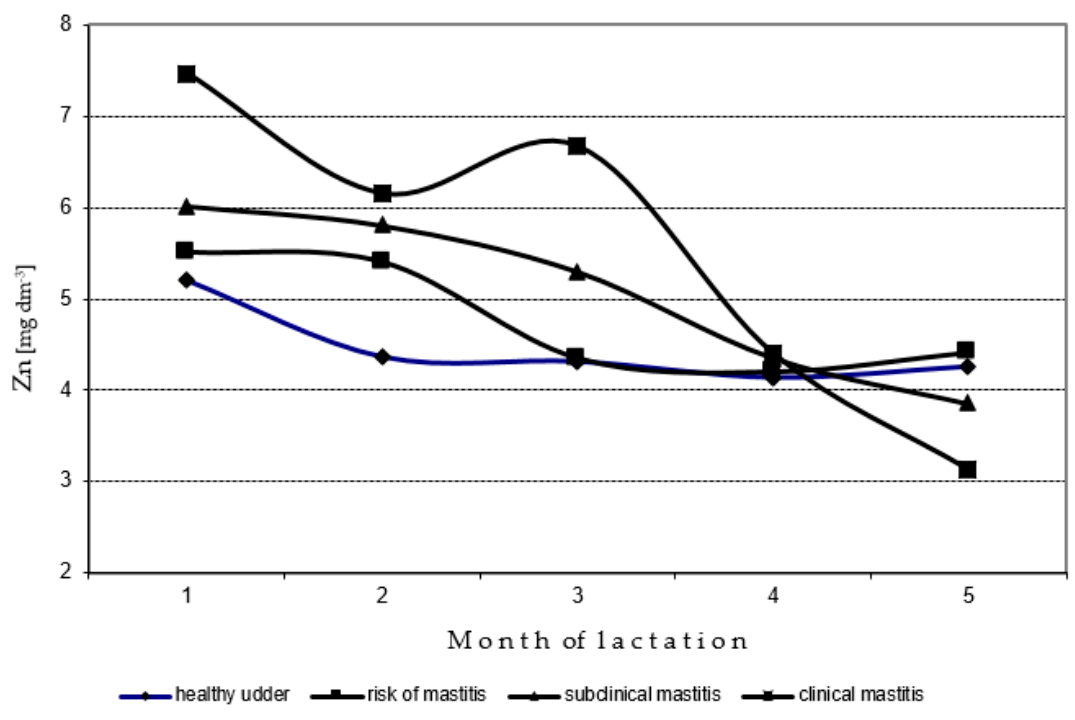
Figure 1. The interaction between the month of lactation and the udder health of cows for the Zn content of milk.